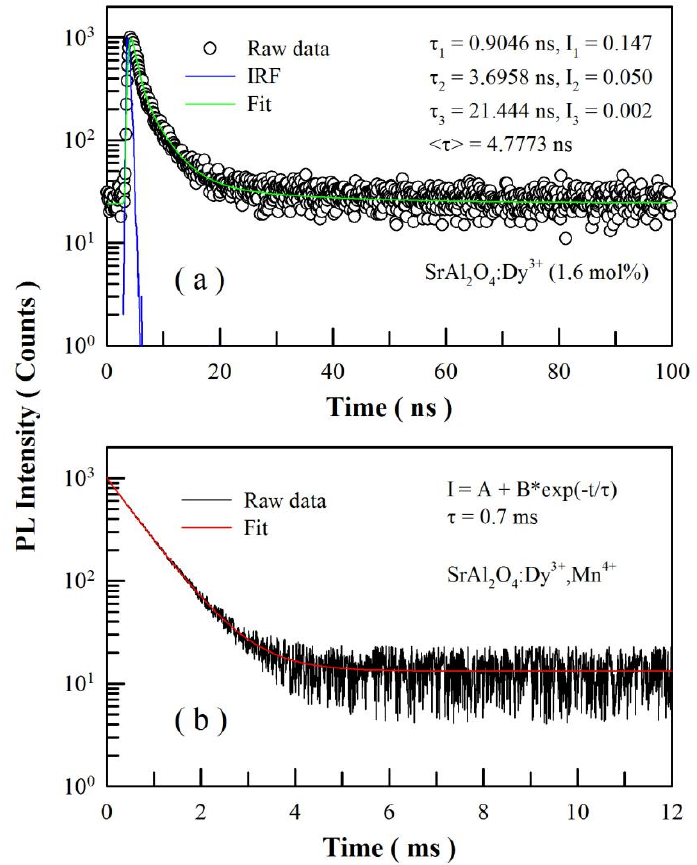
Figure 8. ( a ) PL decay curve of SrAl 2 O 4 :Dy 3+ before Mn 4+ diffusion; the detection wavelengths is 400 nm. ( b ) PL decay curve of CaAl 2 O 4 :Dy 3+ after Mn 4+ diffusion at 1000 °C for 4 h; the detection wavelength is 651 nm. The excitation wavelength is 320 nm.